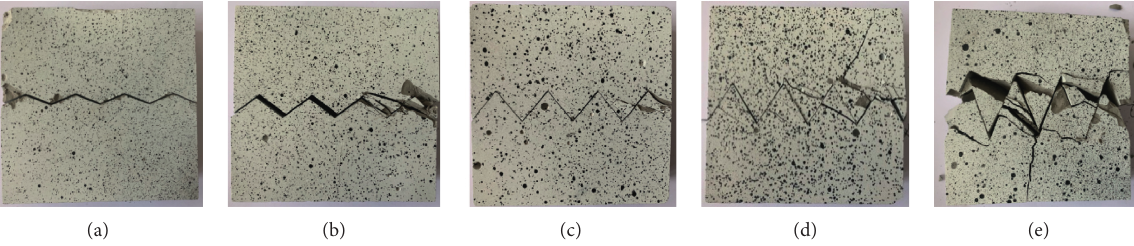
Figure 4: Failure modes of specimens with different undulating heights. (a) B-5. (b) B-10. (c) B-15. (d) B-20. (e)